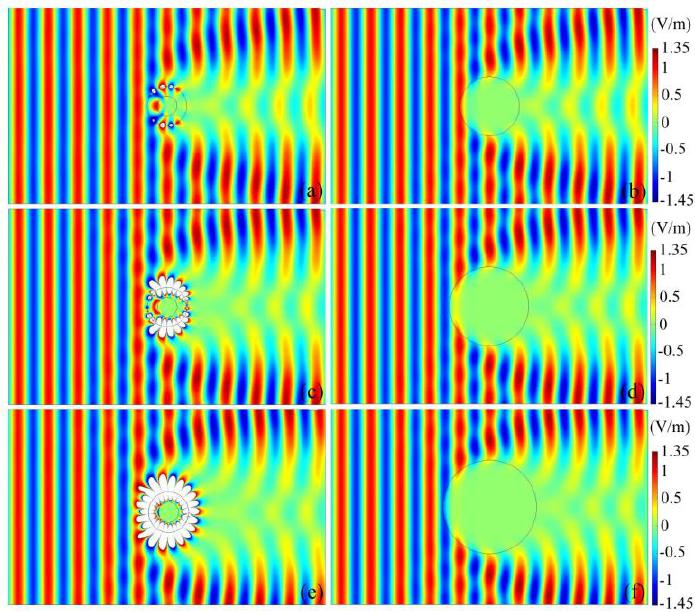
Figure 5. Comparison of the characteristics of the superabsorber based on linear and nonlinear transformations. a, c and e show the electric field distribution of an absorbing core ( ε = –(1– i ) ε ′ , μ = –(1– i ) μ ′ ) with radius of r = 0.05 m and coating with a shell of c c anisotropic negative refractive materials (0.05 m ≤ r ≤ 0.1 m) based on the transformation of Equations (9), (2) and (10), respectively; b, d and f give the electric field distribution in the vicinity of the circular absorbers ( ε = μ = 1– i ) with radius r = 0.15 m, r = 0.2 m and c c 0 0 r = 0.37 m, 0